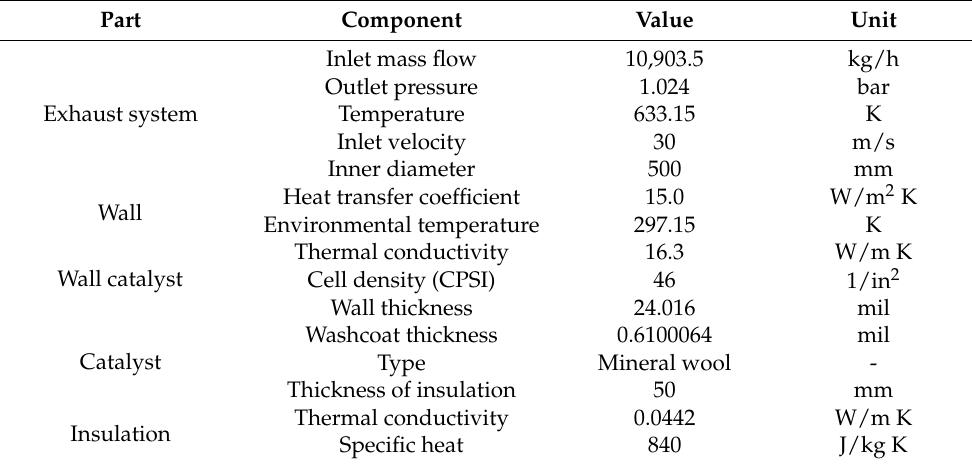
Figure 1. ( a ) Picture of test bed and ( b ) computational modeling of the urea-SCR system. Table 1. Boundary conditions.